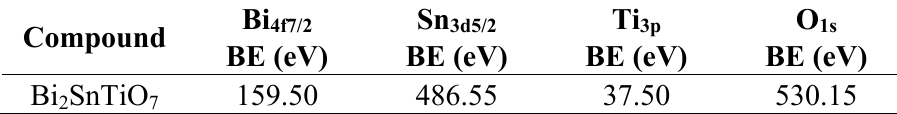
SnTiO , Bi InTaO , pure TiO , N-doped 2 7 2 7 2